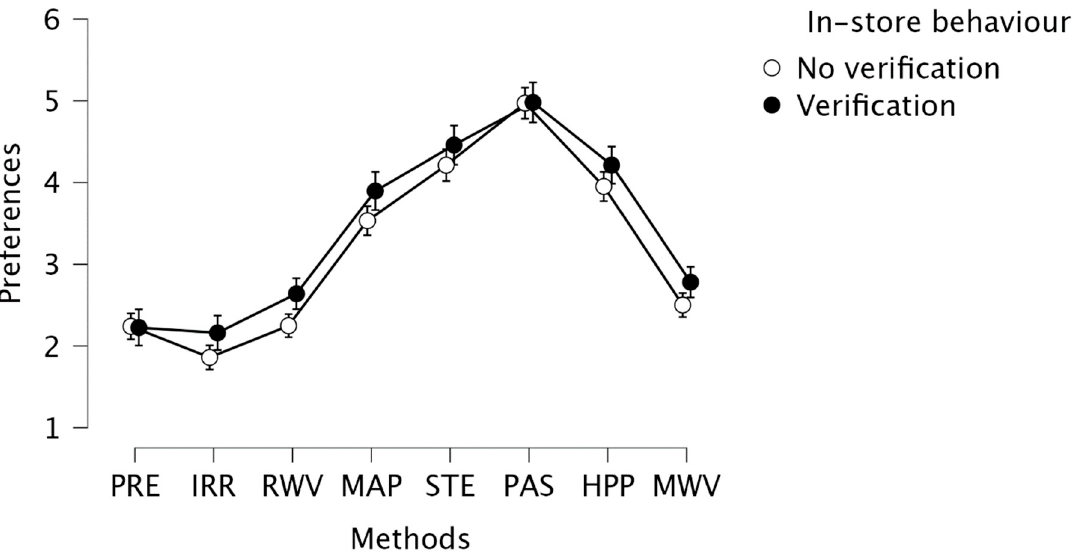
Figure 1. Consumer’ preference for food product preservation methods (PRE—addition of preservatives; IRR—irradiation preservation; RWV—radio wave preservation; MAP—packaging in modified atmosphere preservation; STE—sterilisation; PAS—pasteurisation; HPP—high pressure processing; MWV—microwave preservation).